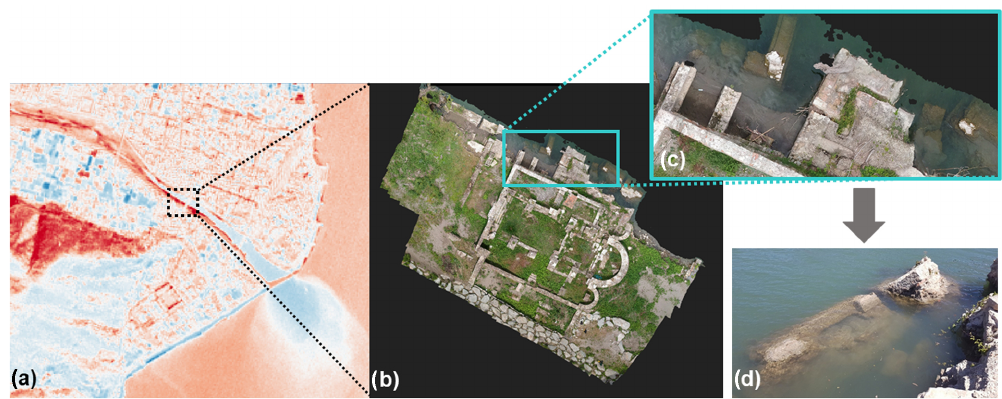
Figure 8. A proposal for a survey workflow including optical multi-spectral and RGB data at different scales: satellite imagery at 10m resolu- tion (a) ; UAV-born orthophoto of the remains pf St. Clement church, elaborated for a scale 1 : 100 (b) and close-up (c) ; photo documentation of the damage visible from the ground caused by the flooding event in November 2016 (d)